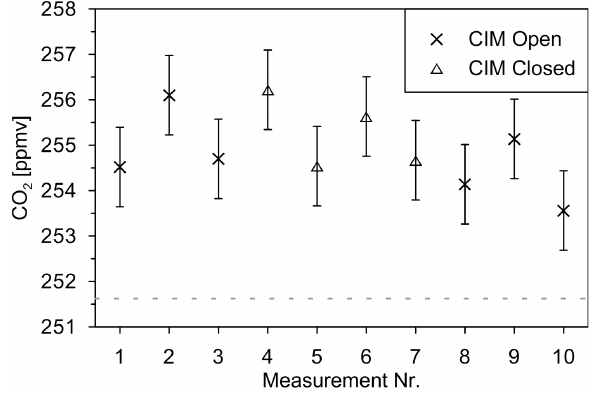
Fig. 5. Measurement results of the CIM system of one day us- ing standard gas with 251.62ppmv CO 2 concentration and gas-free single-crystal ice samples. Crosses represent measurements during which the CIM was opened and the ice was shaved. Triangles show measurements where the CIM was loaded with ice but was kept closed and no ice was shaved. The error bars are equal to the error bar in Fig. 4 for